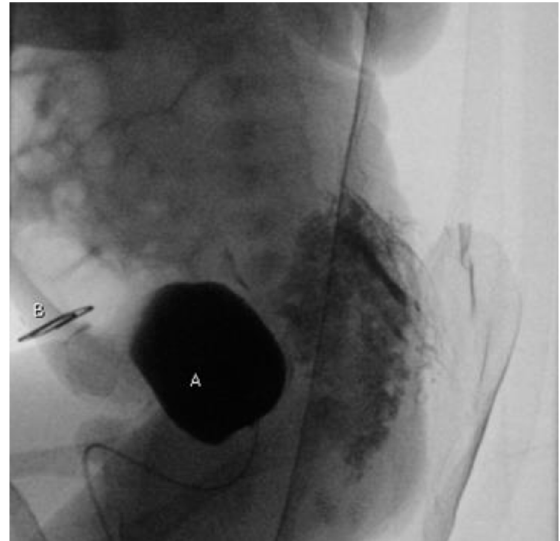
Figure 2. Voiding cystourethrogram (lateral projection): no leakage of contrast medium between bladder ( A ) and exstrophic mucosal plate ( B ) marked with a radiopaque object.